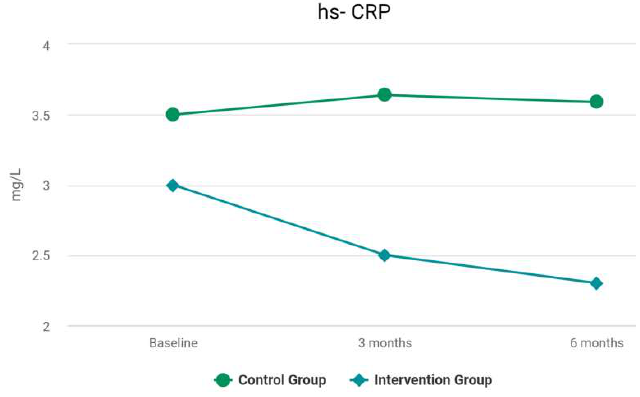
Figure 6. Results of hs-CRP at baseline and during follow-up. Figure 8. Results of hs-CRP at baseline and during Table 4. MANCOVA Results.